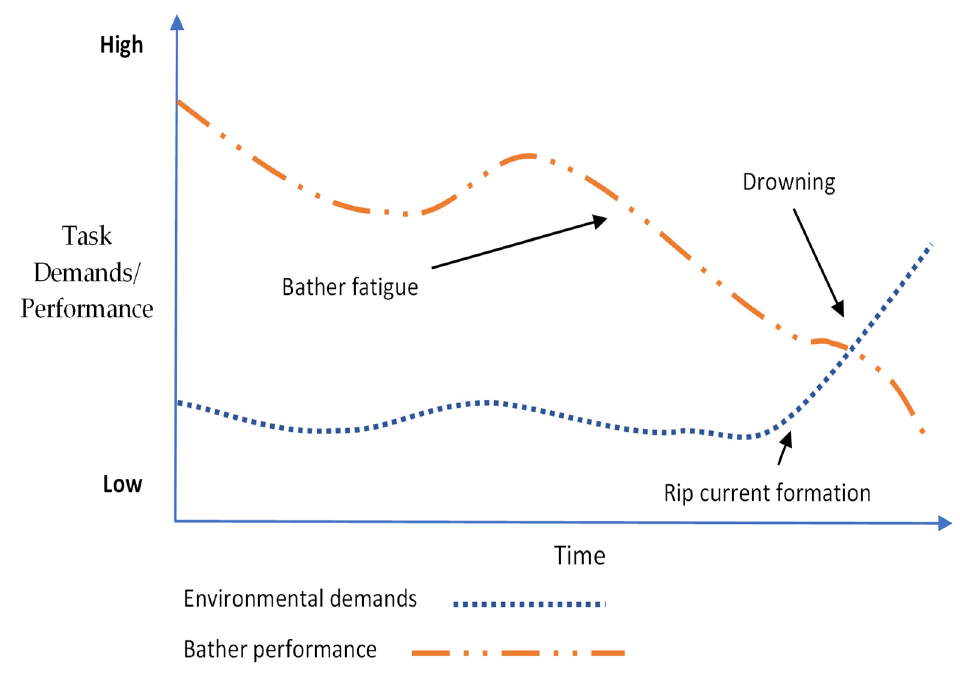
Figure 1. System approach model of surf bather drowning adapted from Blumenthal [9] .